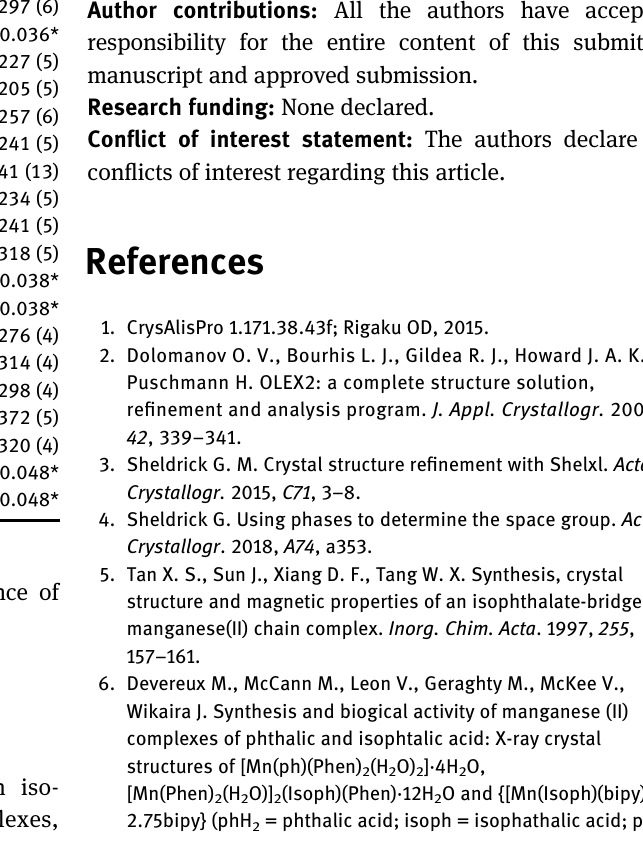
Mn(II) can coordinate 1,10-phenanthroline with iso- phthalate or its derivatives to build complexes,